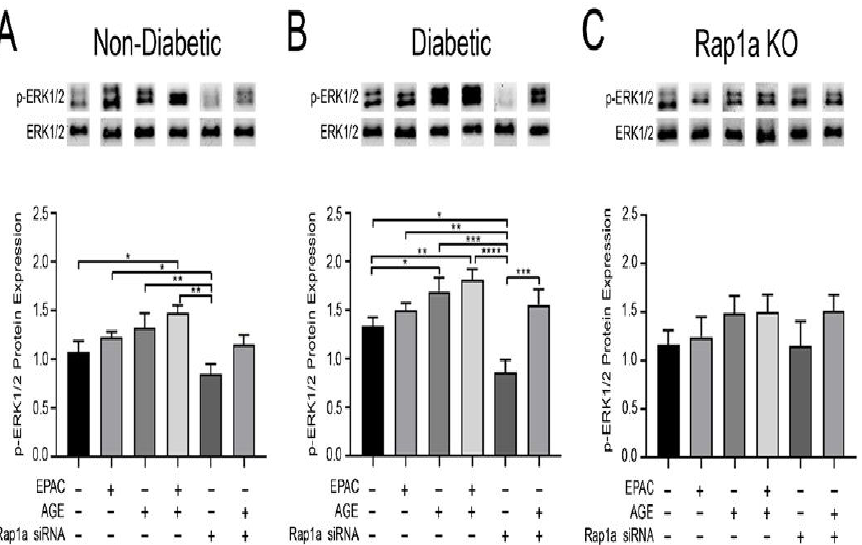
Figure 7. Rap1a mediated AGE/RAGE induced ERK1/2 activation in cardiac fibroblasts. Cardiac fibroblasts isolated from ( A ) non-diabetic, ( B ) diabetic, and ( C ) Rap1a KO mouse hearts were treated with pharmacological modifiers either solo or in combination: EPAC (100 µM), exogenous AGEs (0.5 mg/mL), and Rap1a siRNA (100 nM). Protein expression of p-ERK1/2 (42 and 44 kDa) was normalized to total ERK1/2 (44 and 42 kDa, respectively) expression. Representative western blot images are shown above graphs but are not displayed as a continuous blot due to running order on the blot not aligning with graphical order of samples. However, original western blot images are available at DOI:10.6084/m9.figshare.12625409. Values graphed represent mean ± SEM (n = 6–10) with an one-way ANOVA followed by a Fisher’s protected least significant difference post hoc de- termining significance (* p < 0.05, ** p < 0.01, *** p < 0.001, **** p < 0.0001).